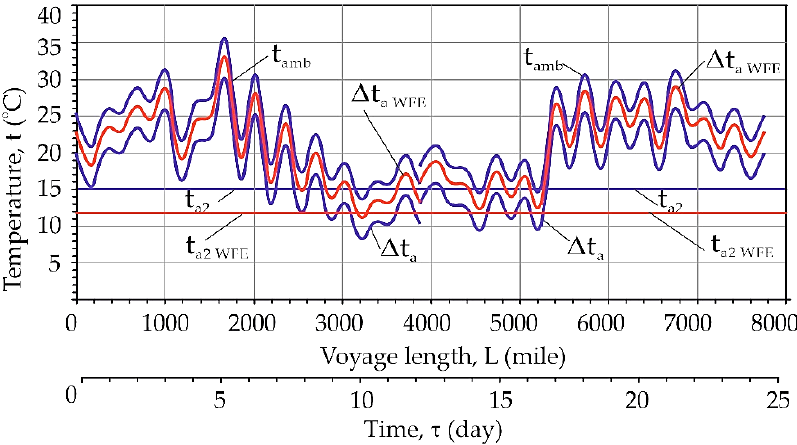
Figure 13. The values of air temperature depression Δt a and temperature t a2 of cooled air at the engine turbocharger suction when using exhaust gas heat and additional scavenge air heat: t a2 and Δt a — fuel oil; t a2 WFE and Δt a WFE — WFE.